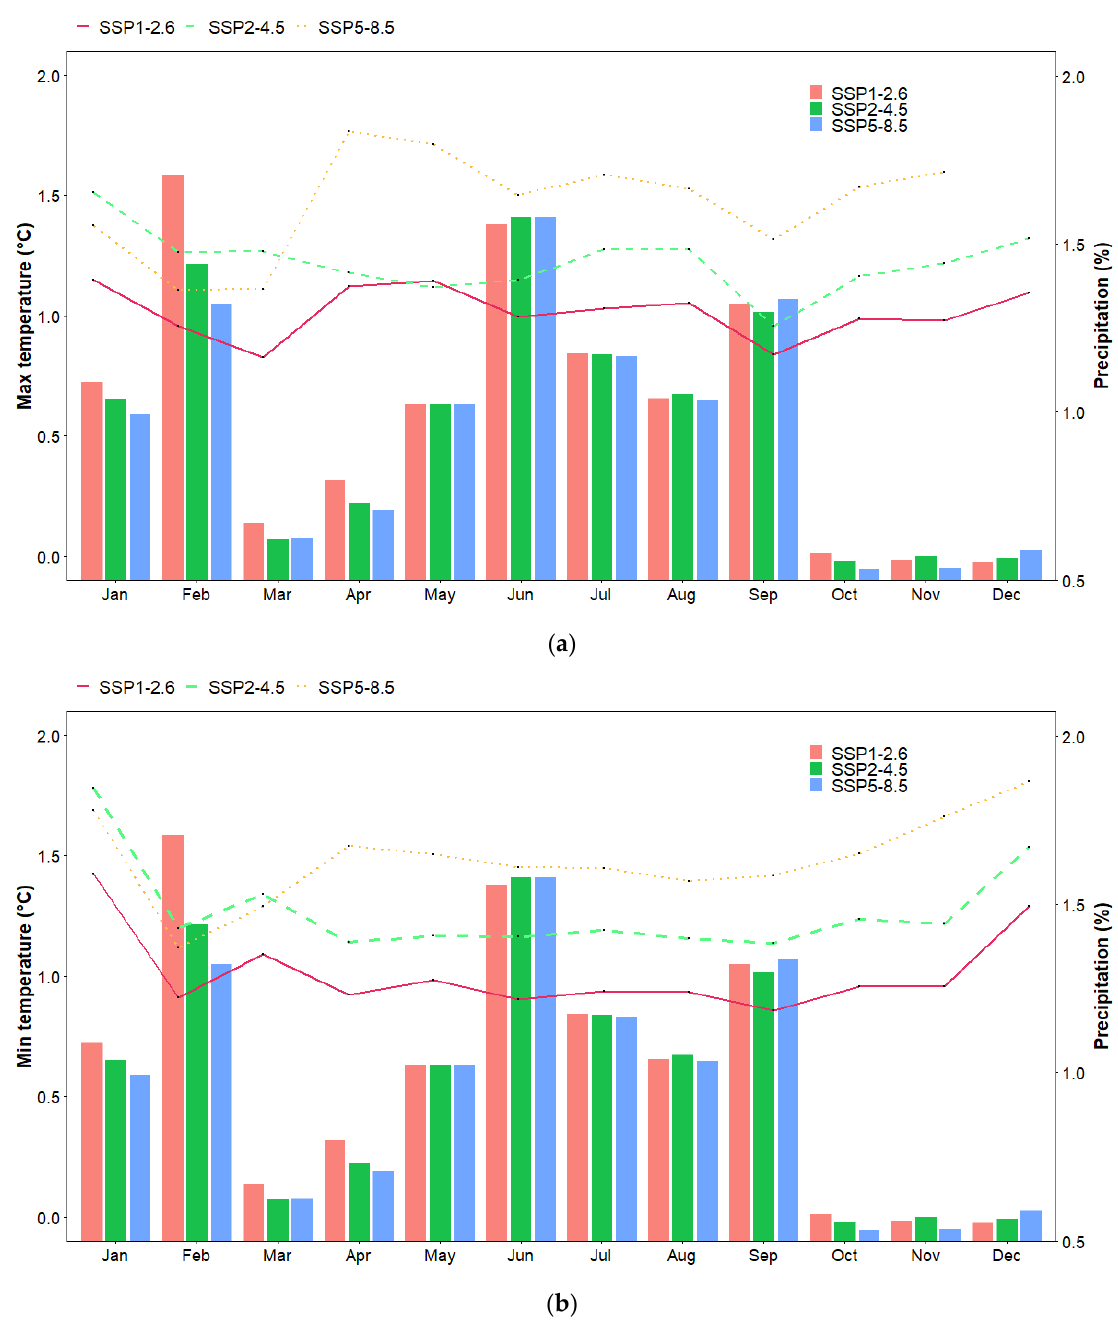
Figure 5. Delta change in precipitation (%) and ( a ) maximum temperature (°C) and ( b ) minimum temperature (°C) under climate change scenarios SSPI 2.6, SSP2 4.5, and SSP5 8.5 in the study area.